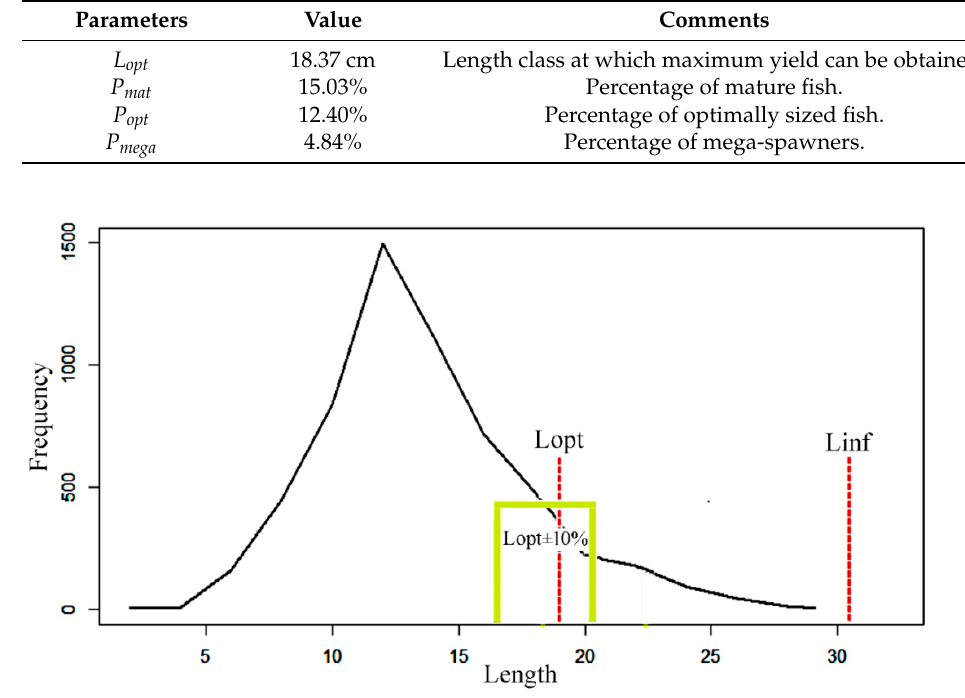
Figure 8. Length frequency distribution of the Bombay duck showing the L ∞ , L opt , and L opt ± 10% of L opt